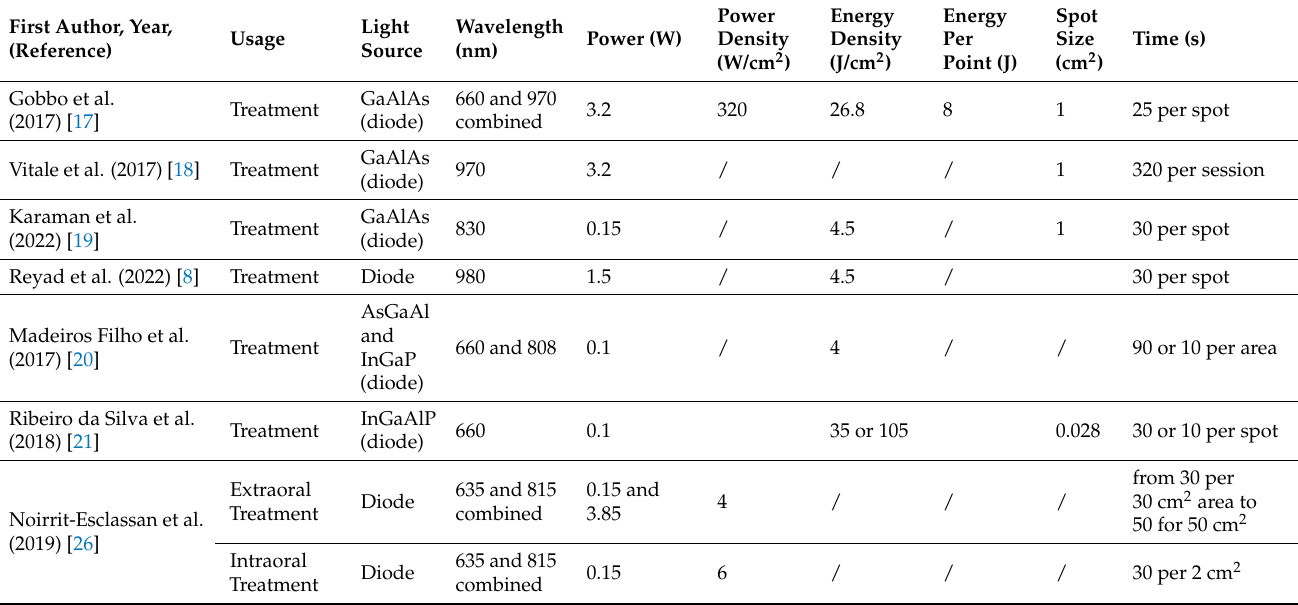
Table 4. Summary of dosimetric parameters used in different clinical